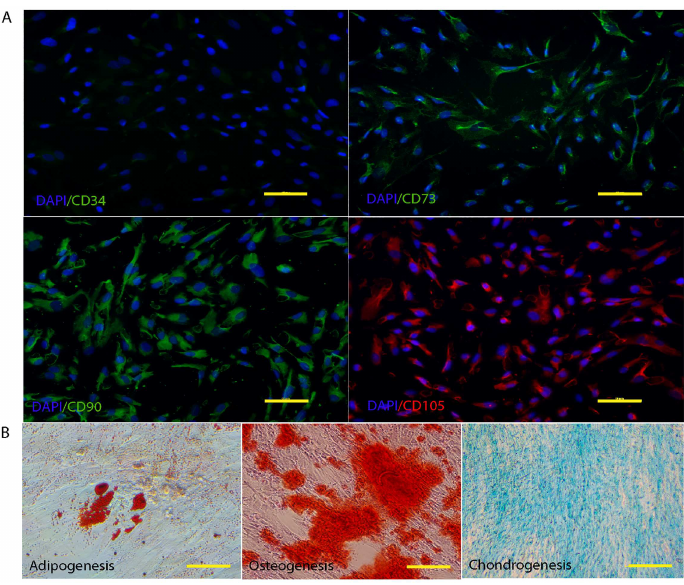
Fig 2. Characterization of hWJ-MSCs. (A) Immunophenotype of MSCs, immunofluorescentmicrographs stainingexpressionof MSC markers (CD73, 90, and 105), Nuclei were counterstains with DAPI (blue). Cells were negative for hematopoietic marker (CD34). Scale bar = 20 μ m. (B) Differentiation of hWJ-MSCs to mesodermal linagecells. The cells were inducedto undergoadipogenic, osteogenic, and condrogenic differentiation.